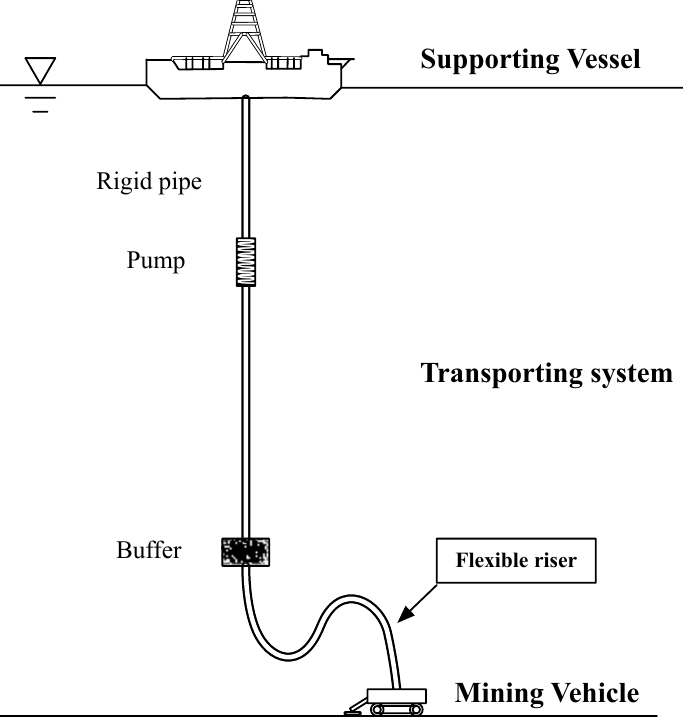
Figure 1. Sketch of a typical deep-sea mining